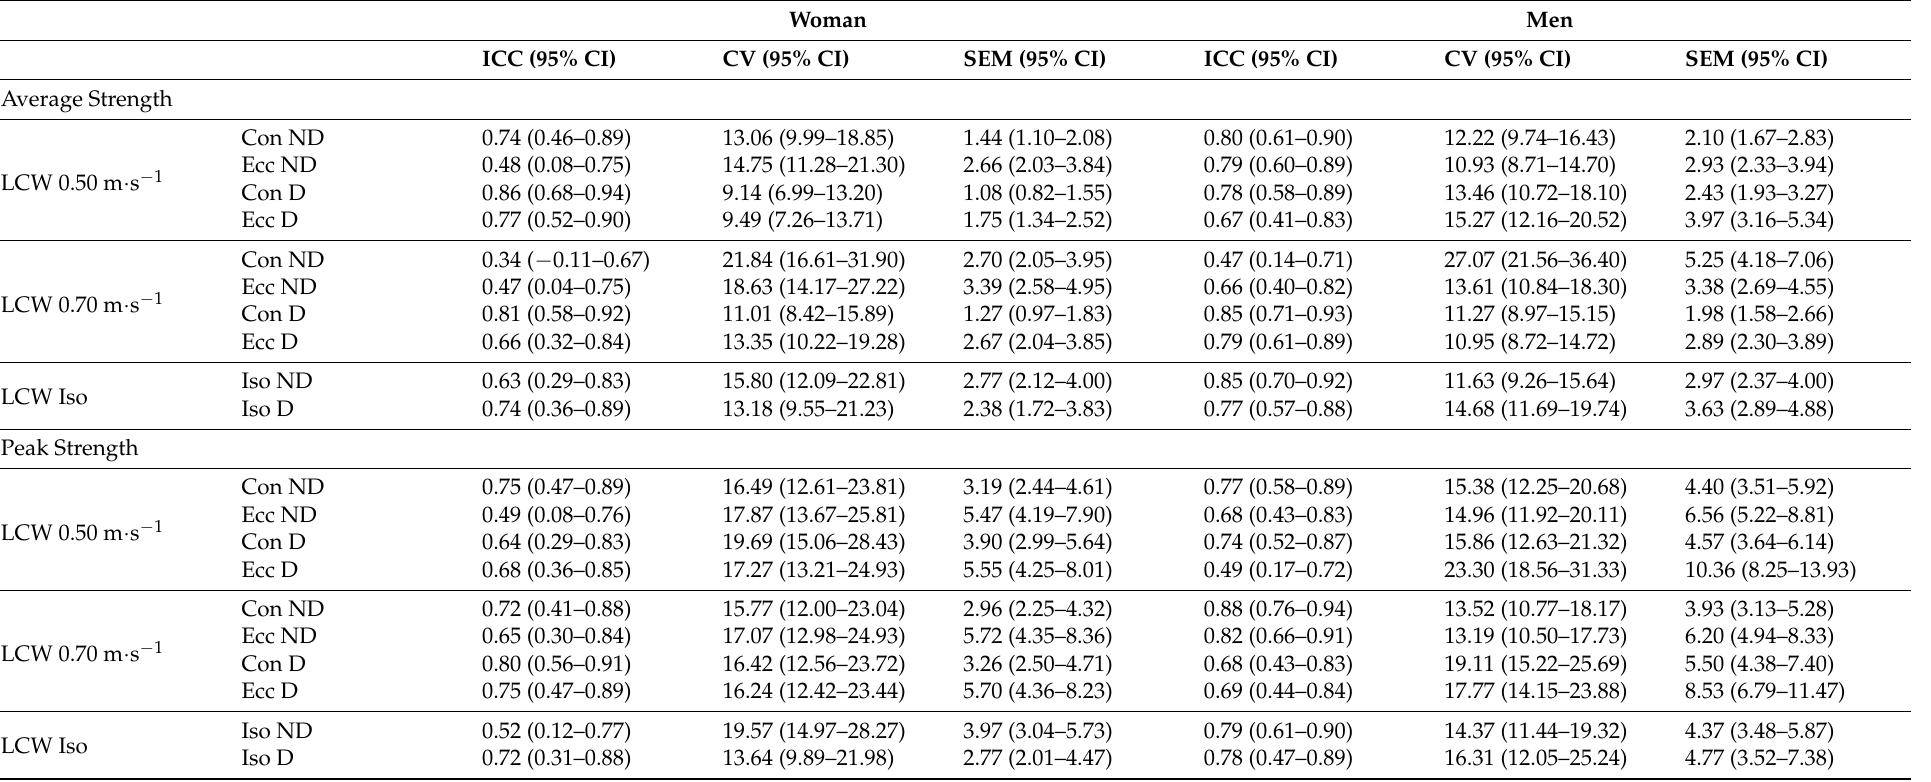
Table 3. Women and men reliability of average and peak strength low cable woodchop